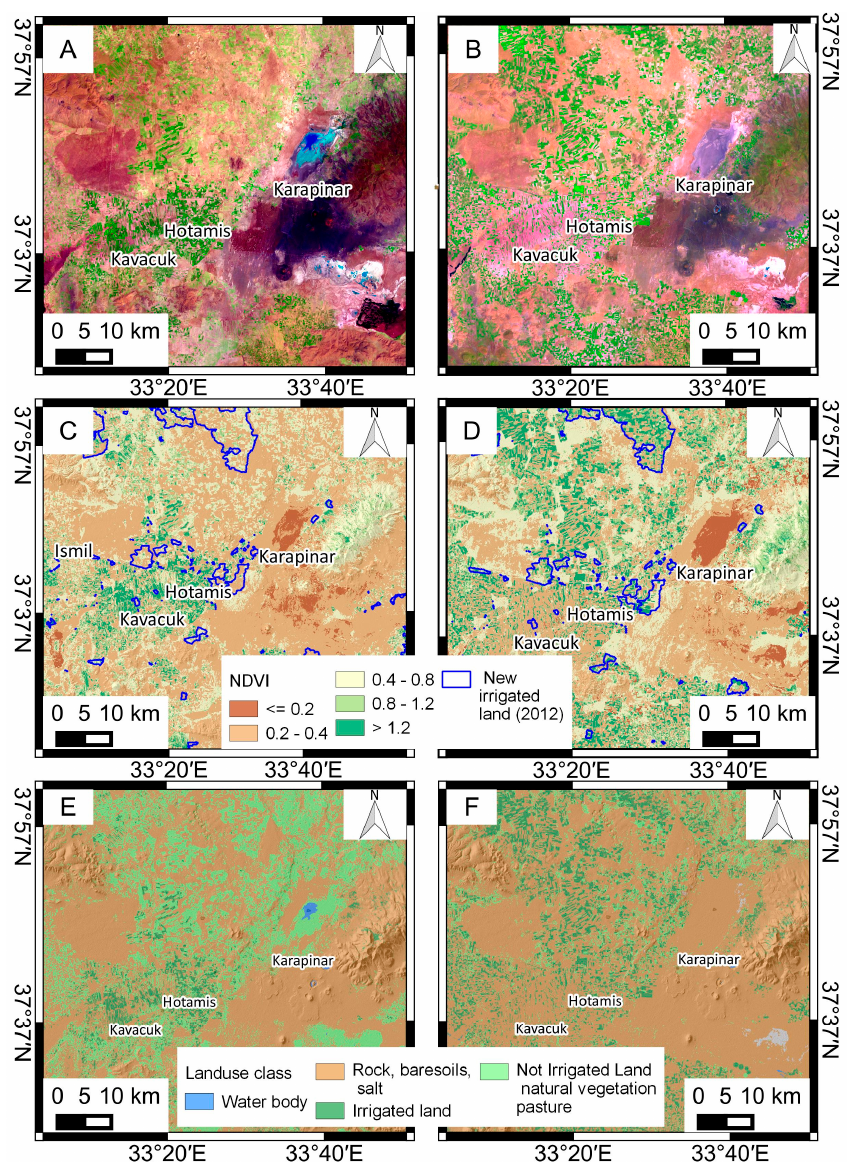
Figure 7. False color images of Landsat 5 TM data (R = Band 5; G = Band 4; B = Band 1) acquired on May 2000 ( A ) and of Landsat 8 data (R = Band 6; G = Band 5; B = Band 2) captured on May 2015 ( B ). ( C , D ) mNDVI images associated to ( A , B ). Blue polygons show areas changed from non-irrigated to irrigated (see Figure 6). Classified Landsat 5 TM ( E ) and Landsat 8 ( F ) images.